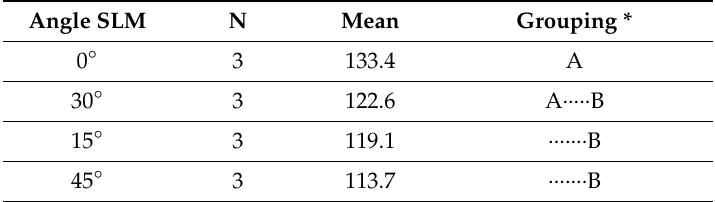
Table 3. Grouping information using the Tukey method and 95% confidence interval on the CA measurements of the SLM